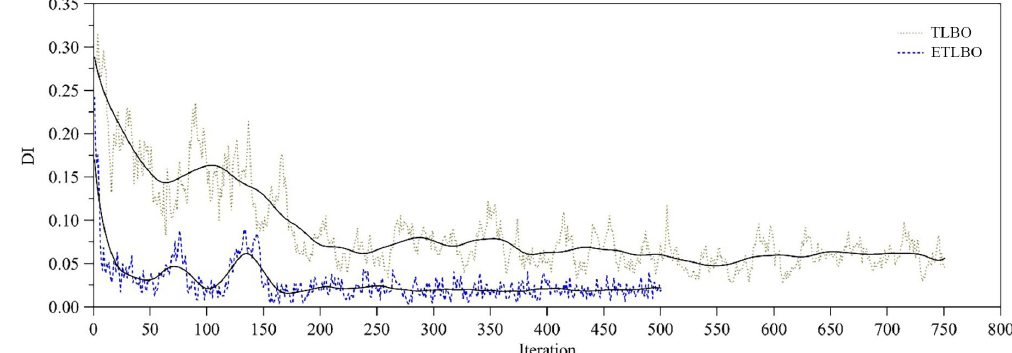
Figure 10. DI traces of ETLBO vs. TLBO for the 582-bar